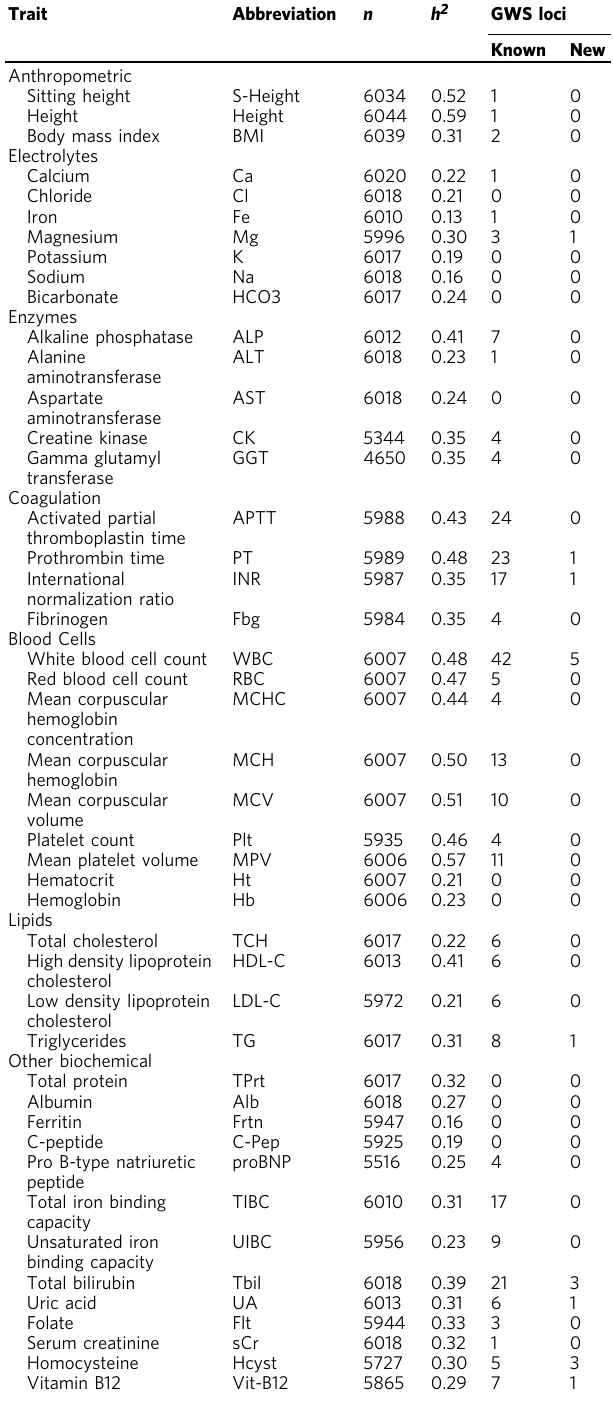
Table 1 Summary of clinically-relevant quantitative traits investigated in this